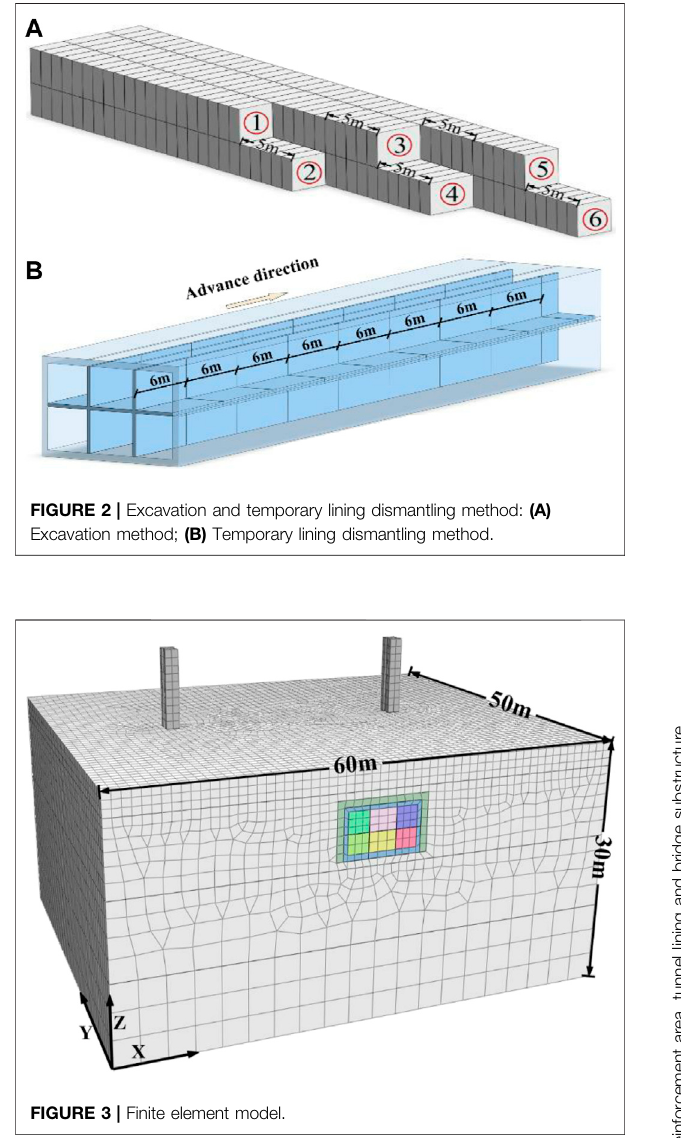
FIGURE 3 | Finite element